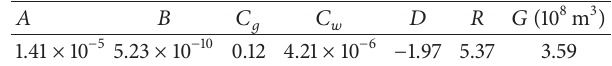
Table 2: The target parameter in an actual